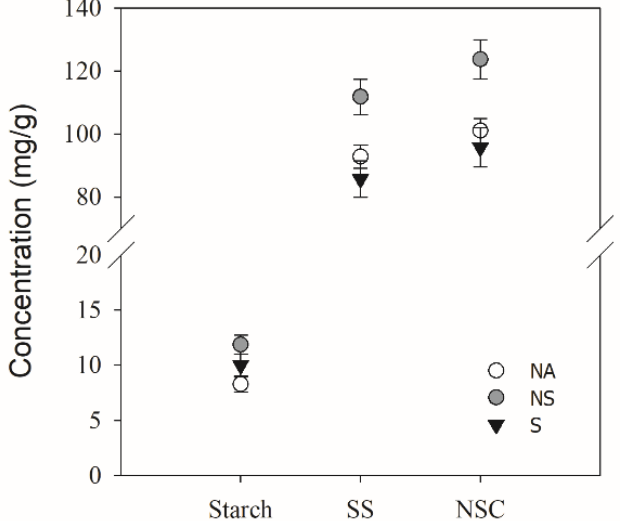
Figure 8. Concentration of starch, soluble sugars and total NSC for each disease degree. Empty circles represent the NA mean values, gray circles represent the NS mean values and black triangles represent the mean S values. Values are the mean ± SE for n = 4 pines per stand and disease degree. Table 2. Summary statistics of Linear Model for the measured variables for disease degrees (NA and NS). Significant differences at p < 0.05 are shown in bold.